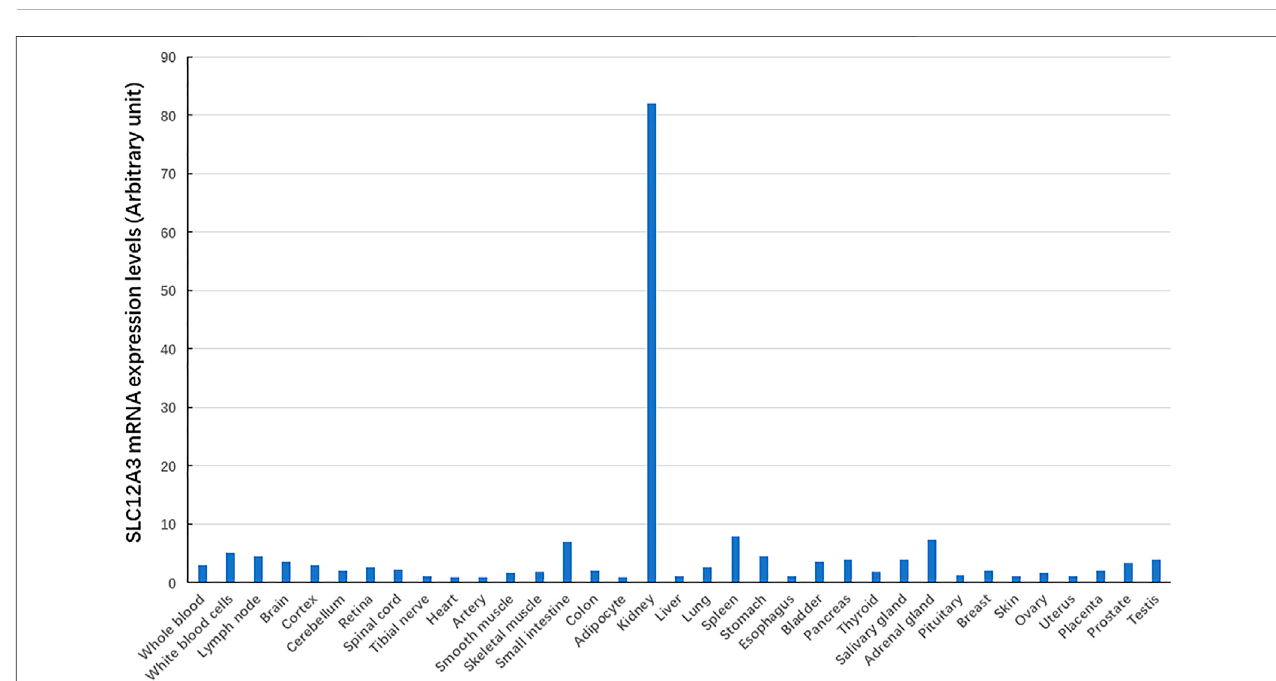
FIGURE2| The SLC12A3 geneexpressionatmRNAlevelsindifferenttissues.The SLC12A3 geneexpressionatmRNAlevelsispredominantinkidneys,butlowin adrenal gland, spleen, small intestine, and other tissues.